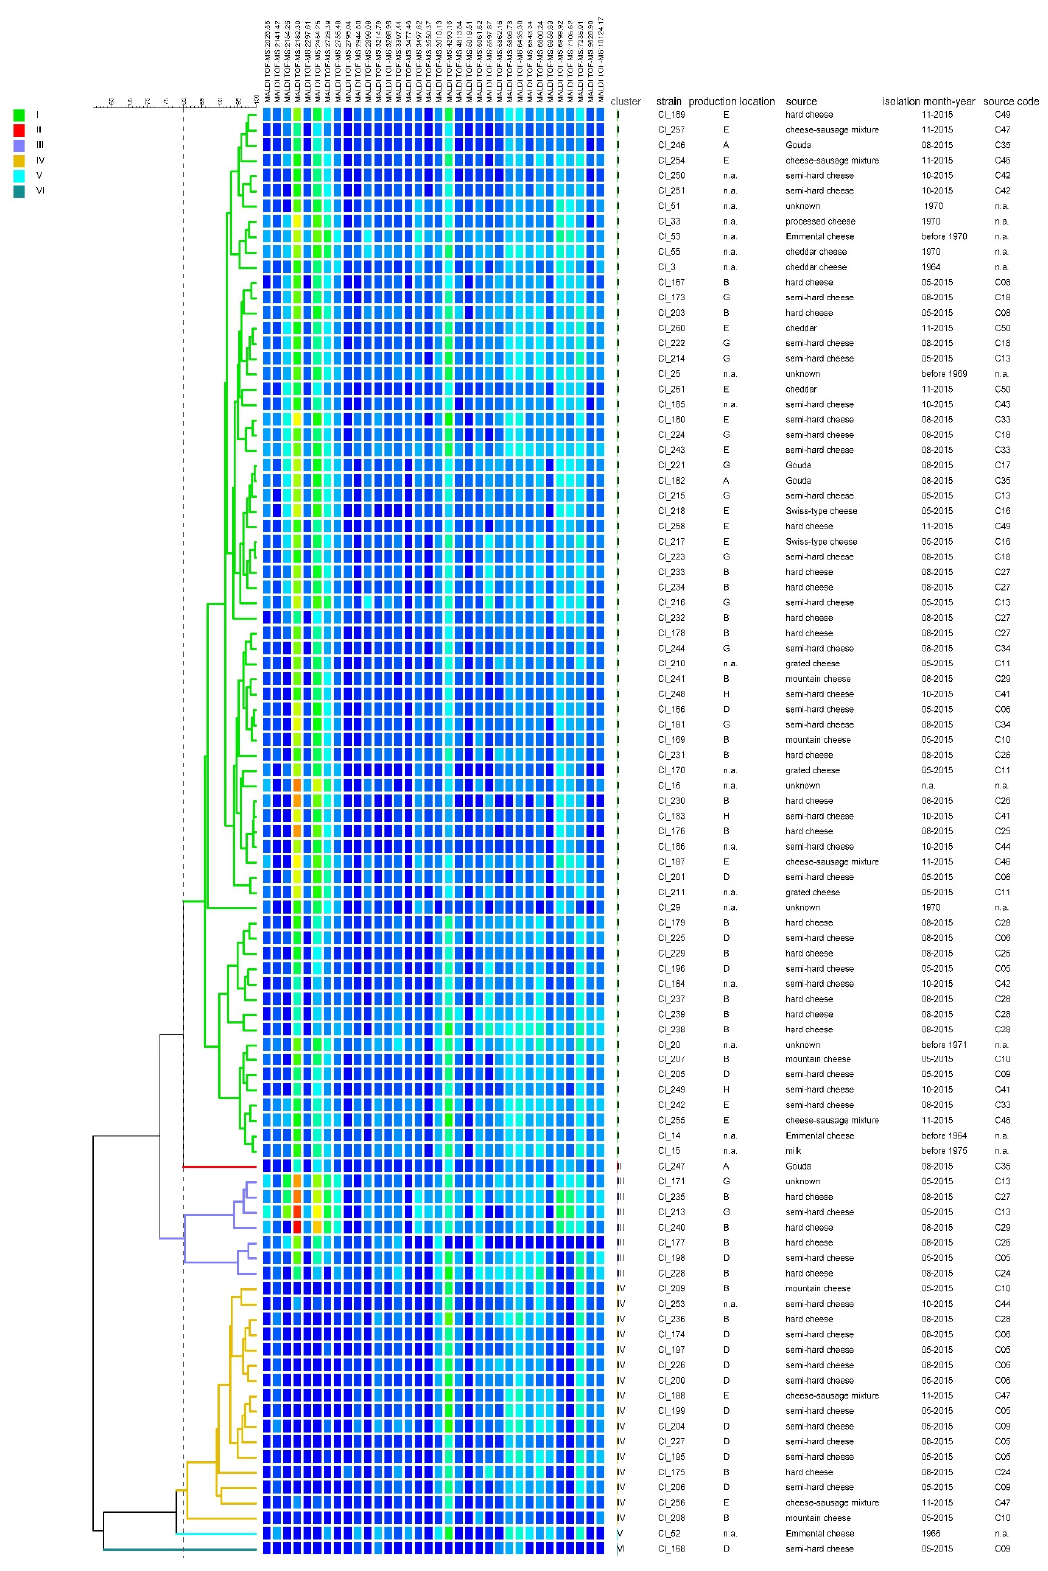
Figure 4. Dendrogram obtained based on the cluster analysis of the MALDI-TOF MS spectra of 95 C. tyrobutyricum strains. The dendrogram was constructed using the unweighted pair group method with arithmetic mean (UPGMA) with similarity levels expressed as percentage values of the Pearson correlation coe ffi cient. The vertical grey dashed line indicates the threshold similarity level (80%) for cluster formation. The color shading indicates peak intensity (from low to high intensity: dark blue, green, yellow, red); n.a. not